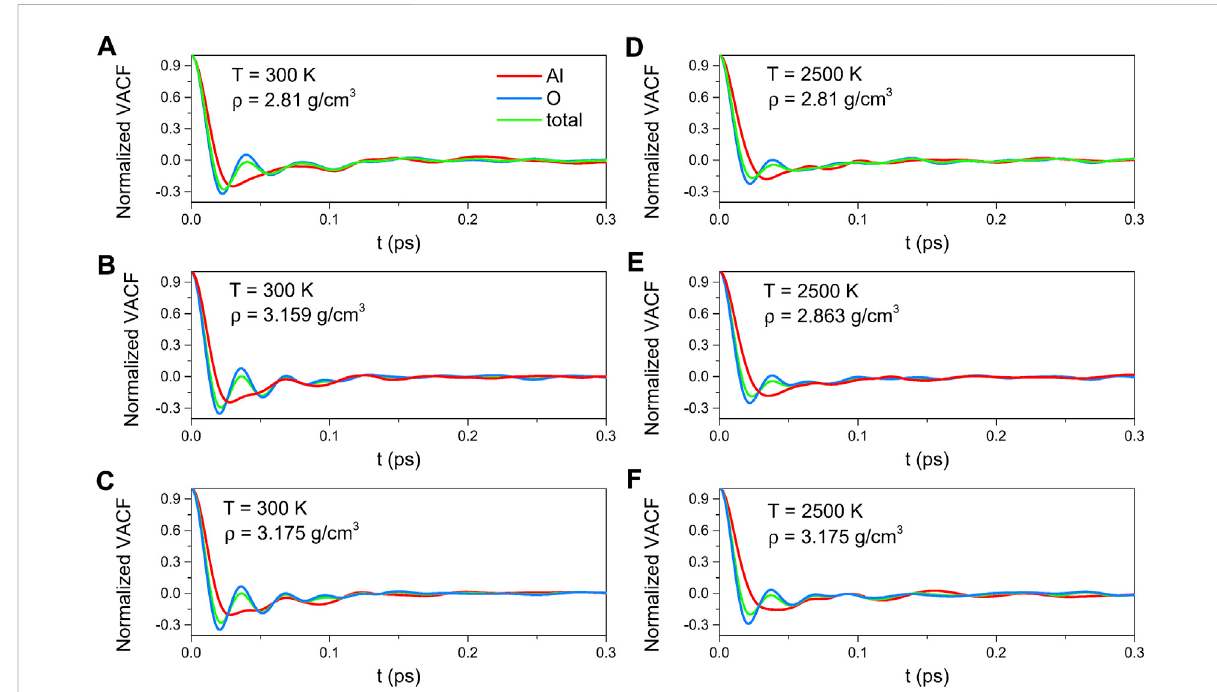
FIGURE 7 Velocity autocorrelation functions for amorphous alumina at 300 K, (A) ρ = 2.81 g/cm 3 , (B) ρ = 3.159 g/cm 3 and (C) ρ = 3.175 g/cm 3 , and for liquid alumina at 2500 K, (D) ρ = 2.81 g/cm 3 , (E) ρ = 2.863 g/cm 3 and (F) ρ = 3.175 g/cm 3